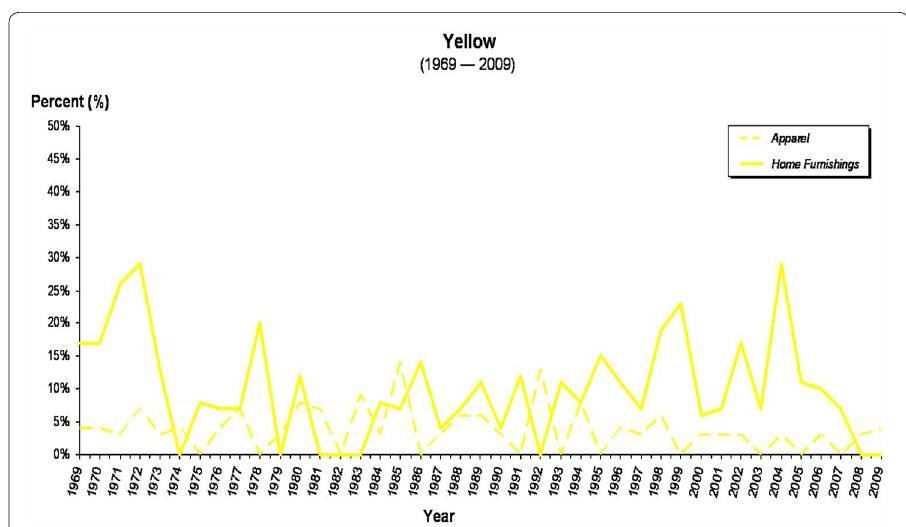
Fig. 1 Yellow: incidences of yellow in home furnishings and apparel